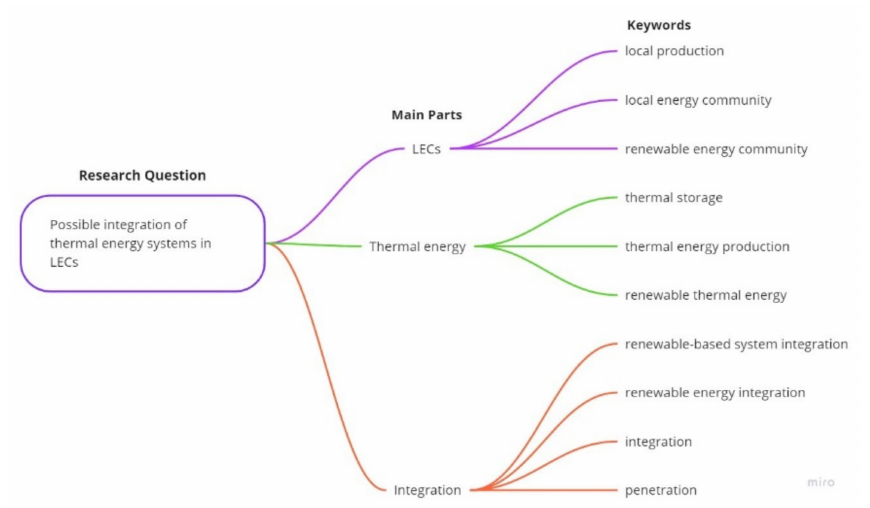
Figure 3. Graphical representation of the keywords targeting the 3rd research